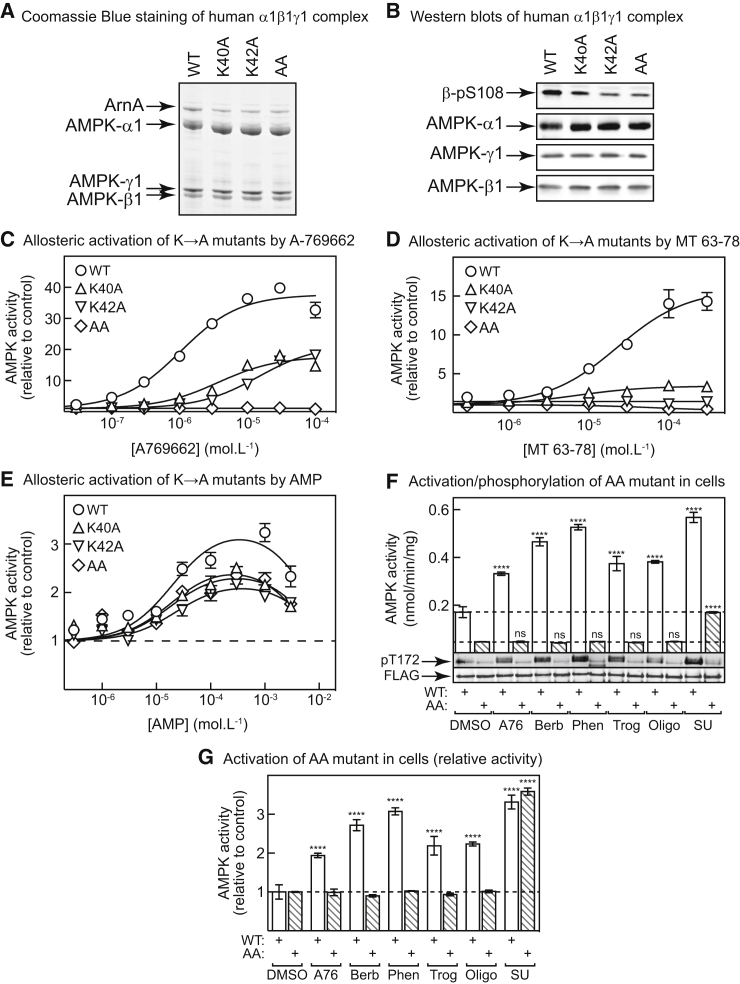
MT 63-78, but Not SU6656, Activates AMPK by Binding at the ADaM Site(A) Coomassie blue-stained gel of purified, bacterially expressed human α1β1γ1 complex, WT or with K40A, K42A, or K40A/K42A (AA) mutations in α1; ArnA is a contaminating protein from Escherichia coli identified by peptide mass fingerprinting.(B) Western blotting of the same preparations as in (A).(C) Allosteric activation of WT and mutant α1β1γ1 complexes (phosphorylated on β1-Ser108 but not α1-Thr172) by A769662. Data are expressed relative to the basal activity in the absence of activator and were fitted to the equation: Y = 1 + ((Activation − 1) × X)/(EC50 + X), where Y is activity, X is activator concentration, Activation is the maximal activation and EC50 is the concentration giving half-maximal activation. Parameters for the WT are quoted in the main text, the Activation and EC50 values for the K40A, K42A, and AA mutants were 18 ± 0.7-fold, 21 ± 0.6-fold, and 1.0 ± 0.03-fold, and 4 ± 0.7, 14 ± 0.6, and 0.001 ± 0.002 μM, respectively; continuous lines are theoretical curves drawn using these parameters.(D) Allosteric activation of WT and mutant α1β1γ1 complexes by MT 63-78, curve fitting as for (C). Parameters for the WT are quoted in the main text, the Activation and EC50 for the K40A mutant were 3.4 ± 0.1-fold and 7 ± 2 μM; fitting for the K42A and AA mutants did not yield sensible values.(E) Allosteric activation of WT and mutant α1β1γ1 complexes by AMP. Data were fitted to the equation for activation/inactivation by AMP (Gowans et al., 2013). Best-fit values for activation and EC50 are given in the main text; values for IC50 were 8.5 ± 4.1, 6.1 ± 1.9, 11.9 ± 3.8, and 8.8 ± 4.6 mM (WT, K40A, K42A, and AA); continuous lines are theoretical curves drawn using these parameters.(F) Activation of WT and AA mutant by various AMPK activators in HEK293 cells. Cells were transfected with DNAs encoding FLAG-tagged AMPK-α1 (WT or AA mutant) and treated with A769662 (300 μM), berberine (300 μM), phenformin (10 mM), troglitazone (100 μM), oligomycin (1 μM), or SU6656 (100 μM) for 1 hr. FLAG-tagged complexes were isolated by immunoprecipitation and AMPK activity determined (mean ± SEM, n = 2). Asterisks indicate significant differences from DMSO controls. The bottom panel shows western blotting of the anti-FLAG precipitates. ****p < 0.0001; ns, not significant.(G) Same experiment as (F), but results expressed relative to DMSO controls. ****p < 0.0001.